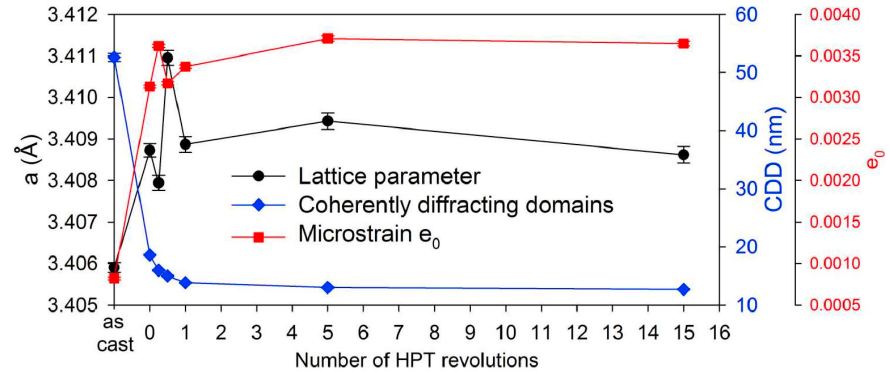
Figure 12. Results of the Rietveld refinement fit the HfNbTaTiZr alloy. The lattice constant a , the size of the coherent diffraction domains CDD and the magnitude of microstrain e 0 are shown in dependence on N . Reprinted with permission from Ref. [144]. Copyright 2018 Elsevier.